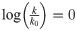
Power spectra as recoverd using CosmoMC analysis with latest BICEP2+Planck data.Allowed area (68% CL) for a fixed ns analysis is shown (blue). Similarly a fixed αs analysis (red), and a fixed βs (green) are shown. The other colores are intersection areas. The pivot scale in this graph is at log(kk0)=0, where k0 = 0.05 hMpc−1. The apparent divergence in high k’s is due to the inability of Planck to constrain these k’s. With more data, it will be possible to differentiate between the three possibilities.